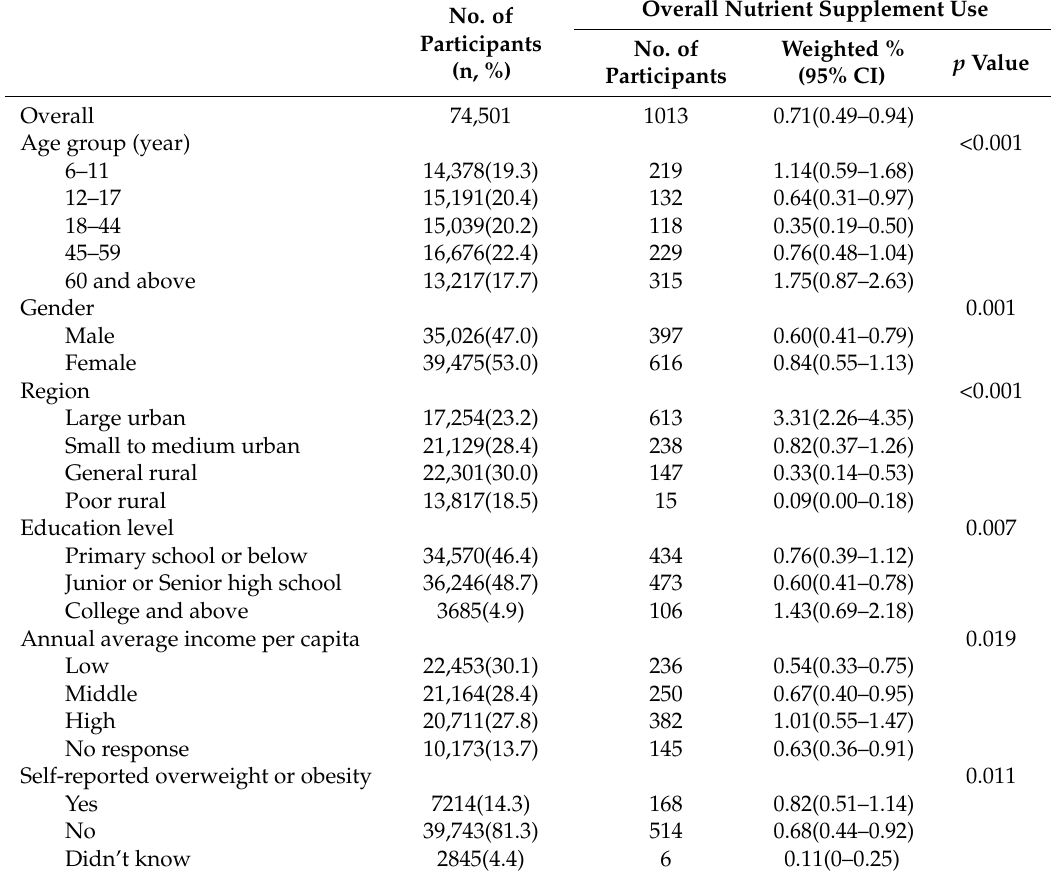
Table 1. Nutrient supplements use among the Chinese population aged 6 years and above. No.